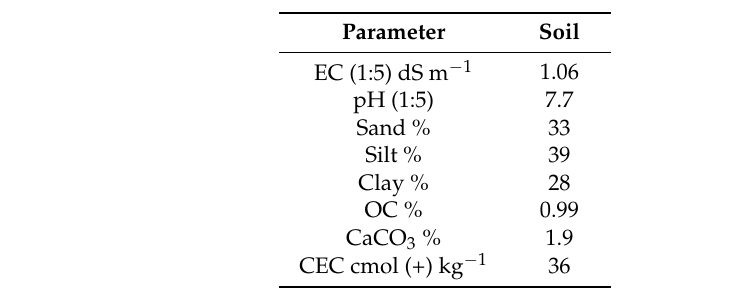
Table 1. The chemical and physical properties of the soil at the experimental site.